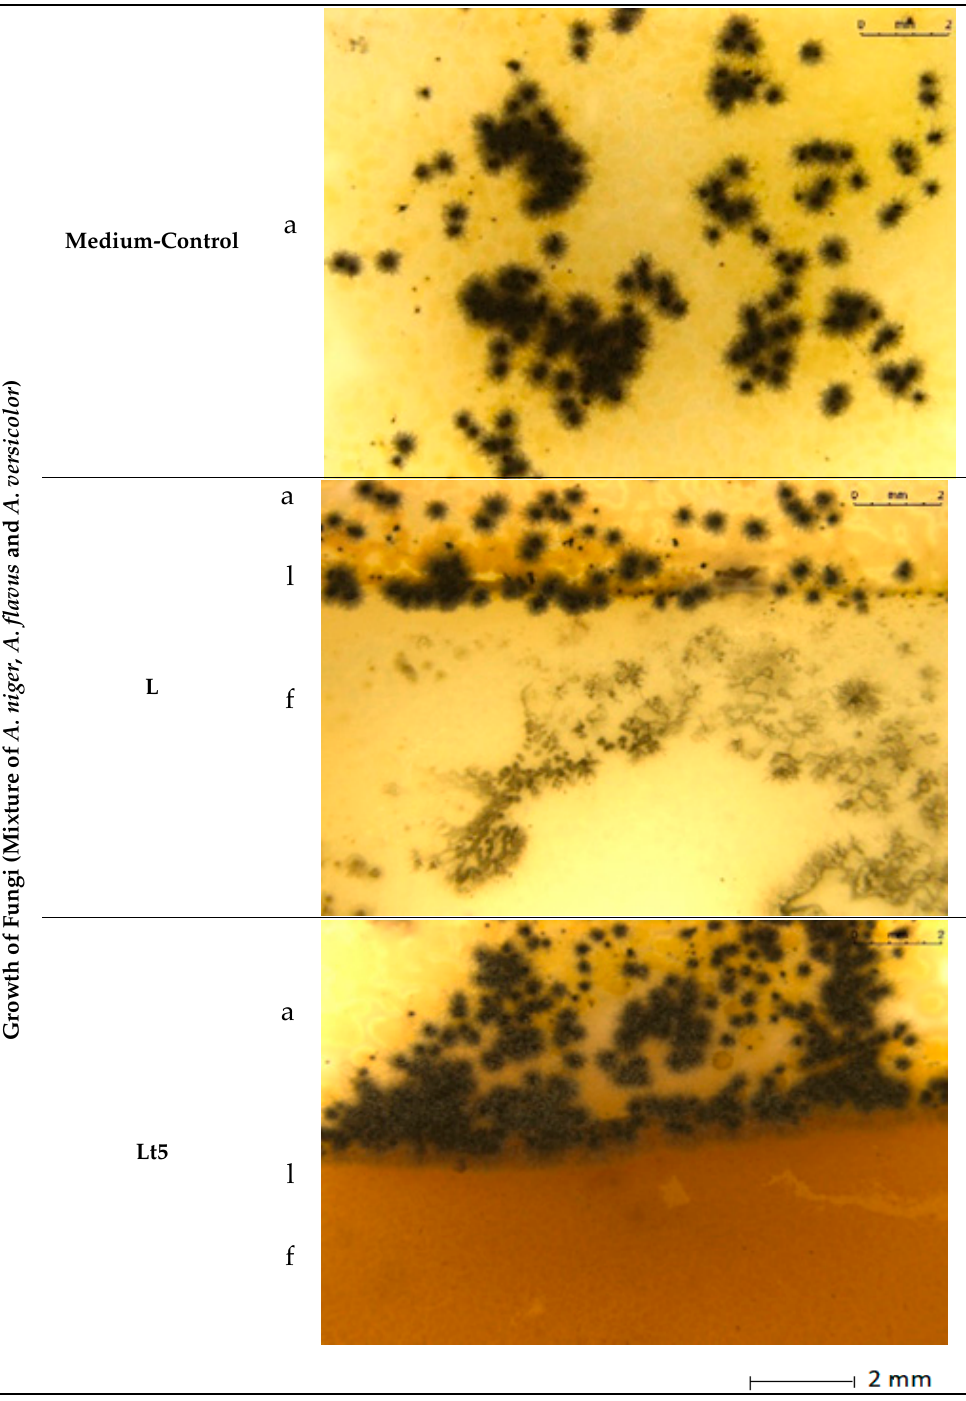
Table 5. Growth of fungi mix on the surface films without (L) and with birchtar (Lt5) . Abbreviations: a—agar with fungi, l—line (between agar with fungi and the film), f—film.